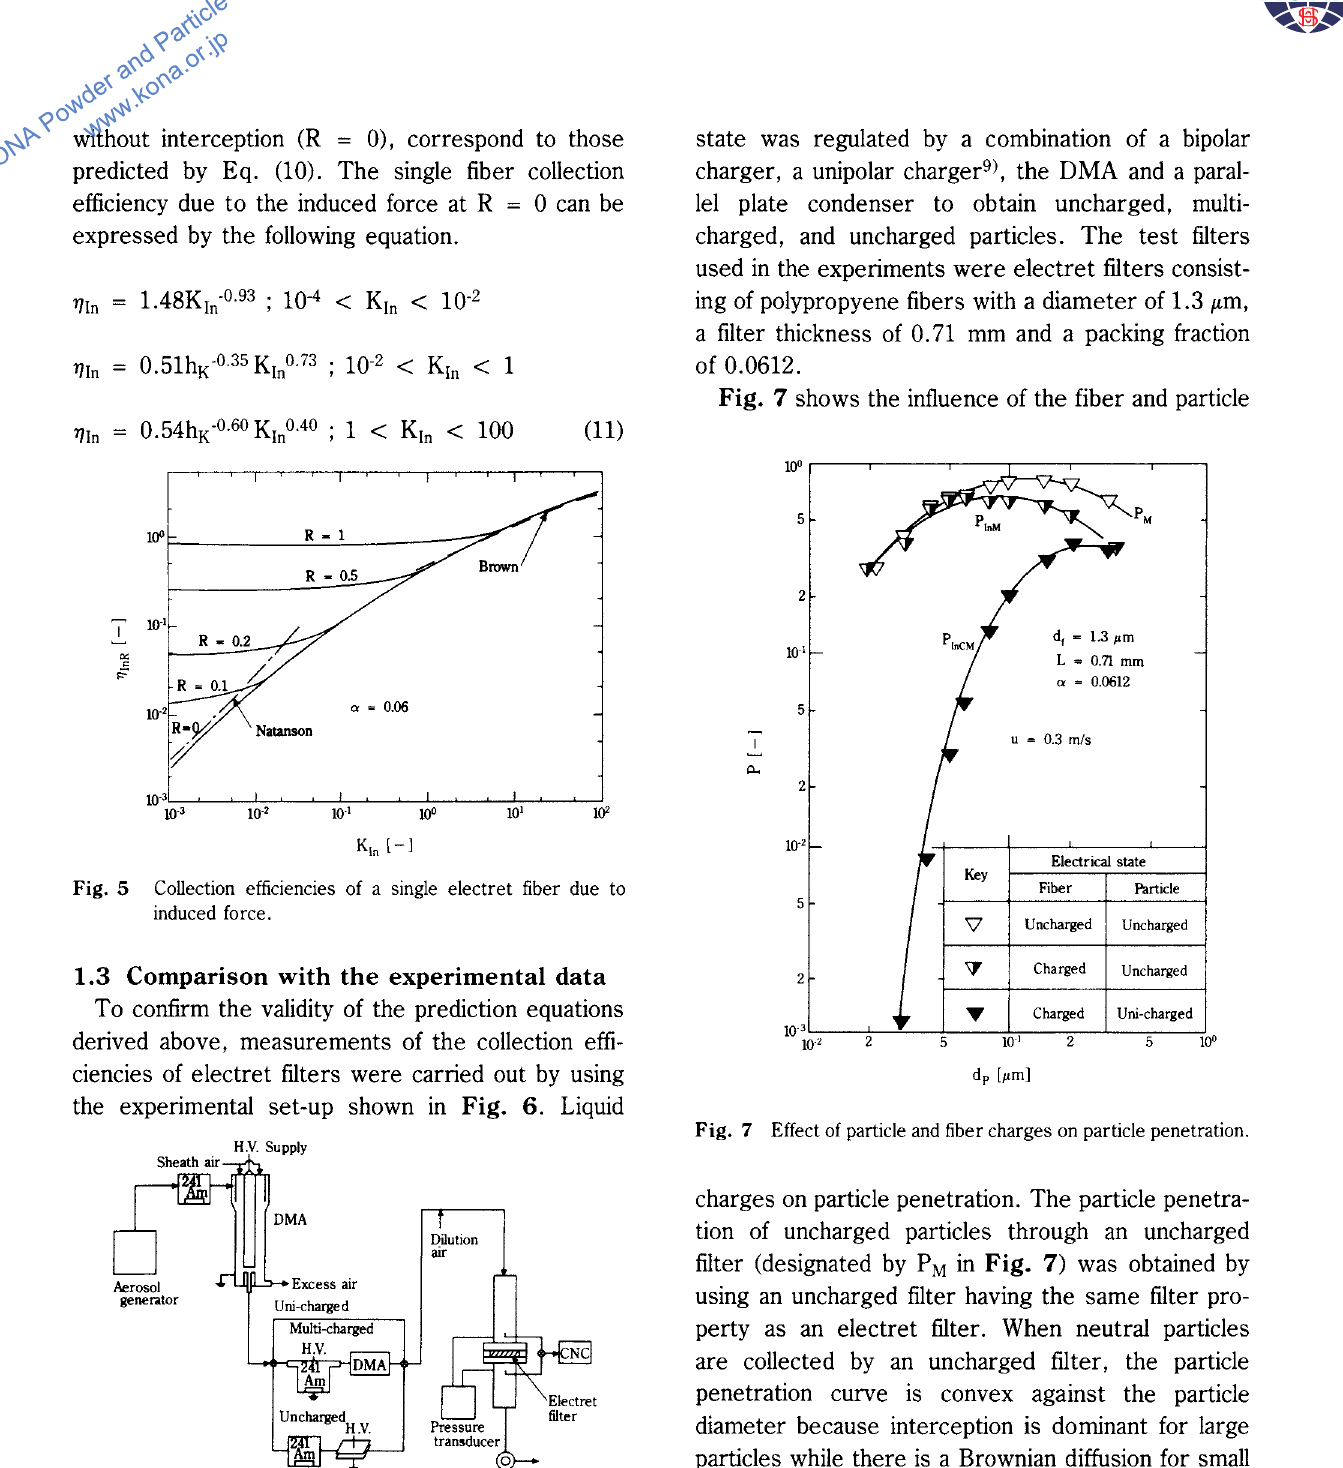
Experimental setup for the measurement of particle penetration through electret filters.